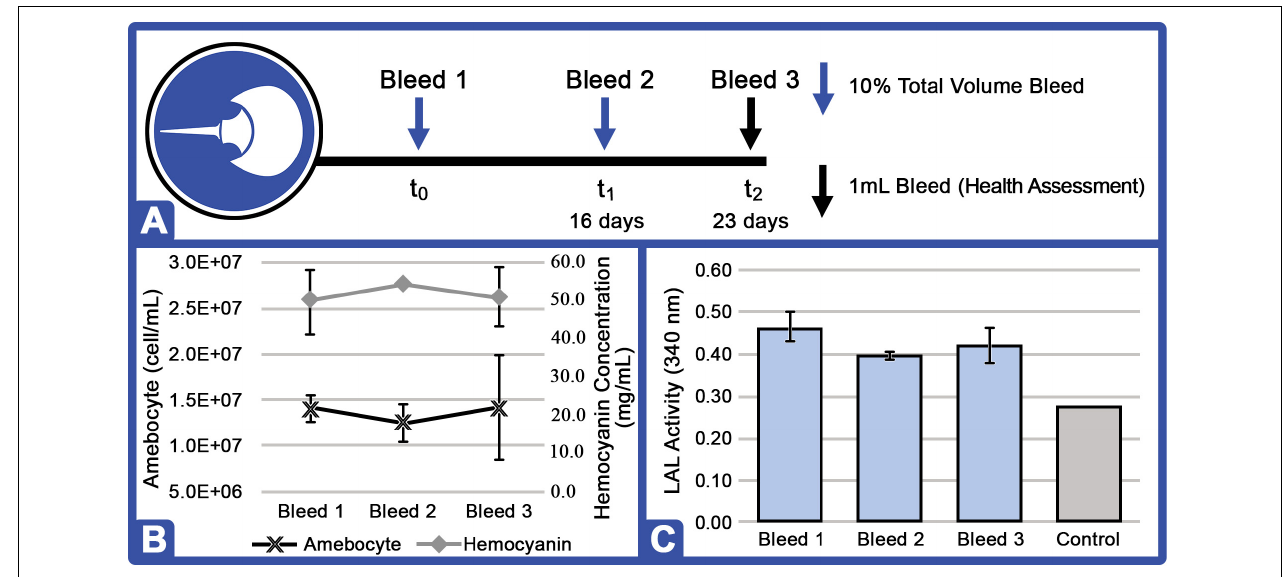
FIGURE 7 | Amebocyte density, hemocyanin concentration, and LAL activity of aquaculture HSC after repeat hemolymph collection. (A) After 6 months of aquaculture, each HSC ( n = 4) was bled at t 0 and t 1 (16 days after t 0 ) for 10% total hemolymph volume and returned to the RAS, and a final health assessment sampling (1 ml bleed) was performed at t 3 (23 days after t 0 ). (B) Representative HSC amebocyte density and hemocyanin concentration. (C) Aquaculture HSC LAL activity after bleeds compared to control (commercial kit LAL; Sigma E-Toxate TM ) at the same protein concentration (300 µ g protein) exposed to 50 EU/ml of LPS.